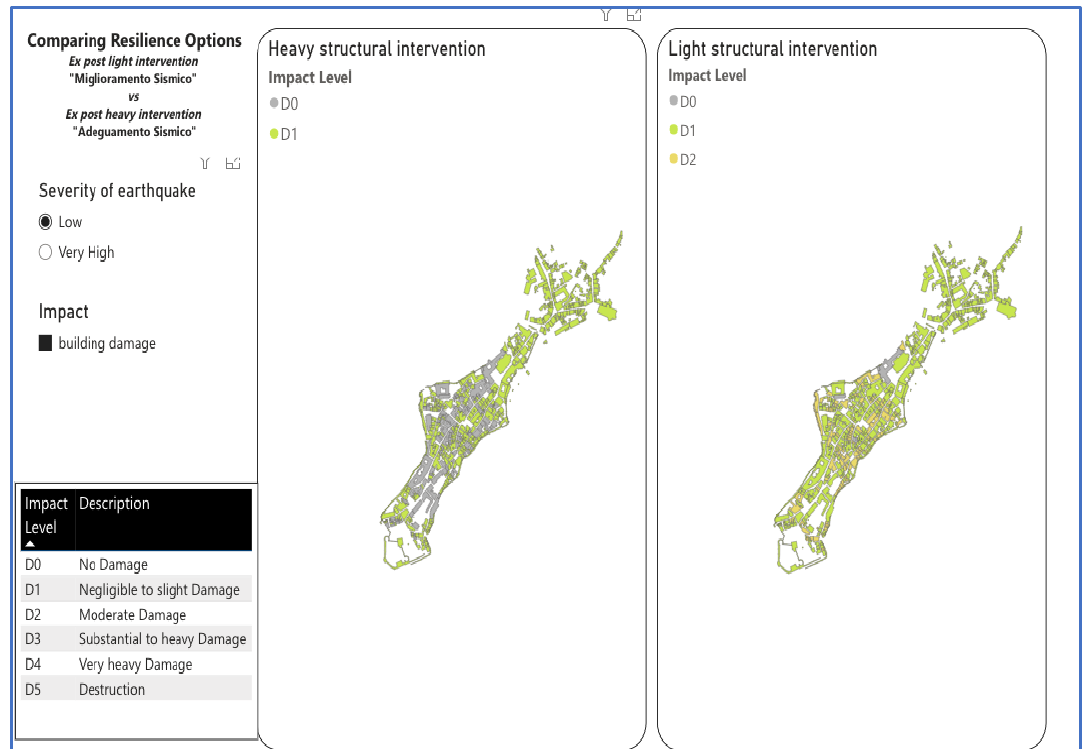
Figure A2. Comparative Visualization of ex post impact scenarios of two different resilience options so that their different effectiveness can be seen and compared.